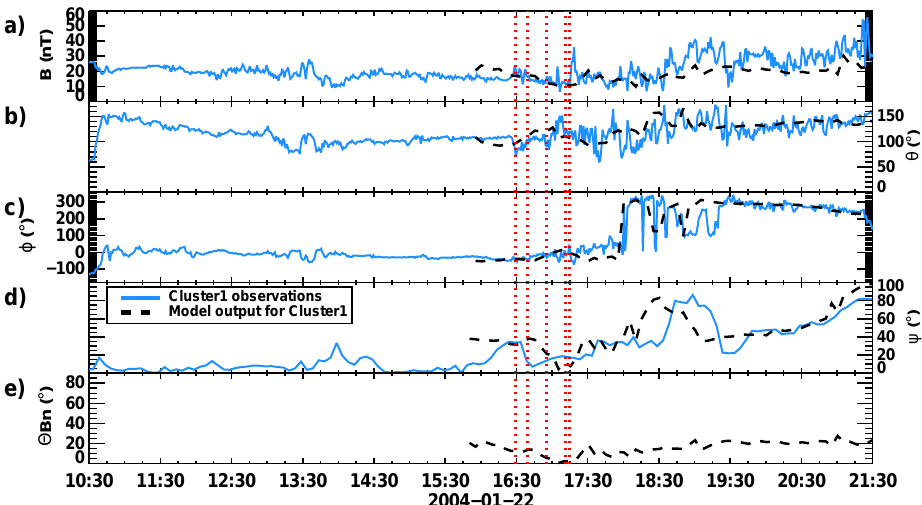
Figure 8. 22 January 2004 MC: comparison between the magnetosheath model’s results (dashed black lines) and Cluster’s observations (solid blue lines), in GSE coordinates. Same format as Fig.